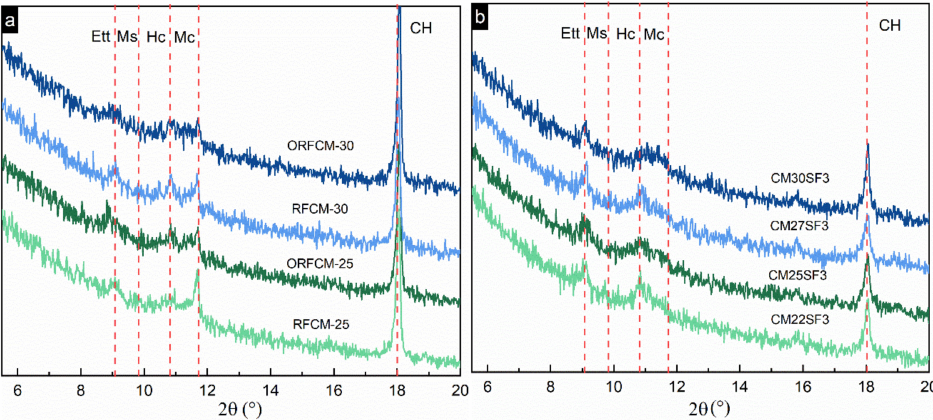
Figure 10. XRD patterns of opitimized and non-optimized samples ( a ) and samples ( b ) blended with silica fume at the age of 90 d (Ett = ettringite, Ms = monosulfate, Hc = hemicarbonate, Mc = monocarbonate).